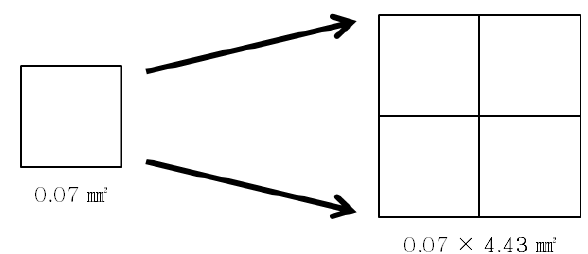
Figure 3. Schematic diagram of pixel size expression according to magnification (pixel size is rounded to the nearest hundredth)